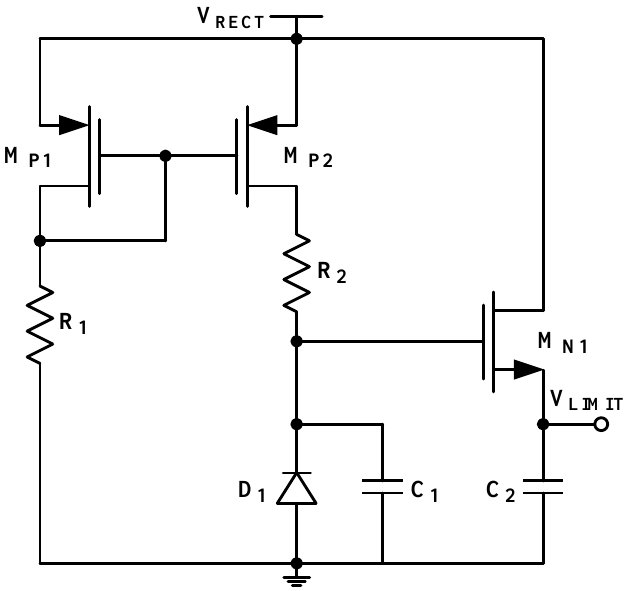
Figure 2. Circuit diagram of the proposed limiter in the PRC.